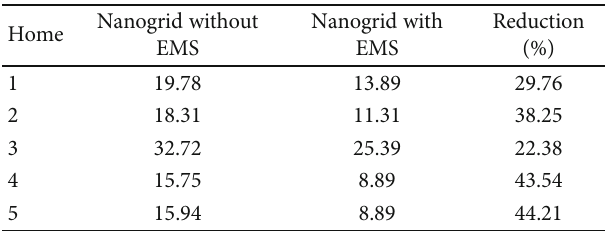
Table 8: Nanogrid power consumption comparison without EMS and with EMS.